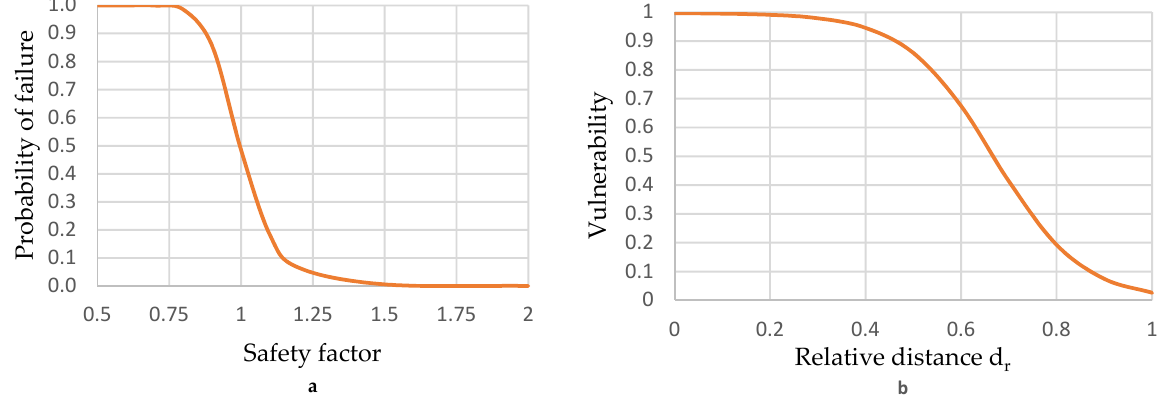
Figure 4. ( a ) Probability of failure versus safety factor; ( b ) inverted logistic S curve for the estimation of vulnerability from the relative distance d r .